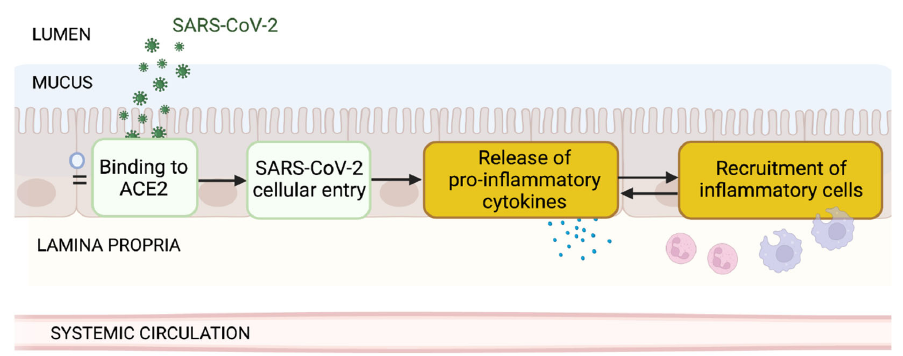
Figure 3. Pathway depicting the sequence of events of SARS-CoV-2 enteric infection contributing to the inflammatory response. This manuscript assesses whether evidence supports these events.